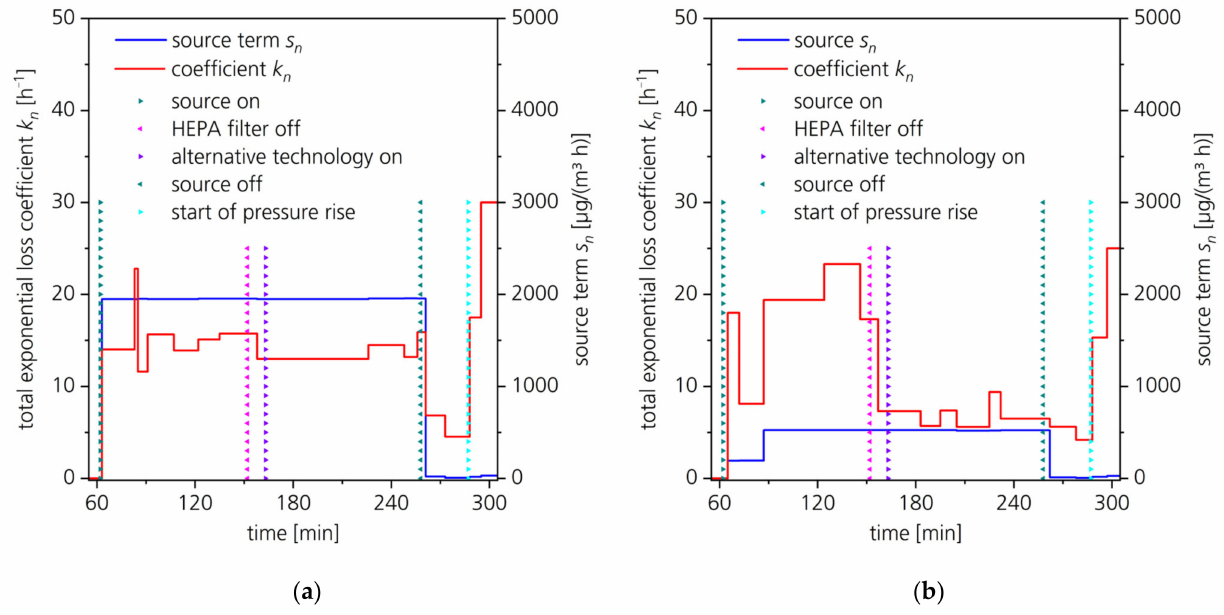
Figure 6. Fitted parameters k n and s n and changed parameters like source on/off, start of pressure rise, and change of air cleaning technique: ( a ) k n and s n at position 2; ( b ) k n and s n at position